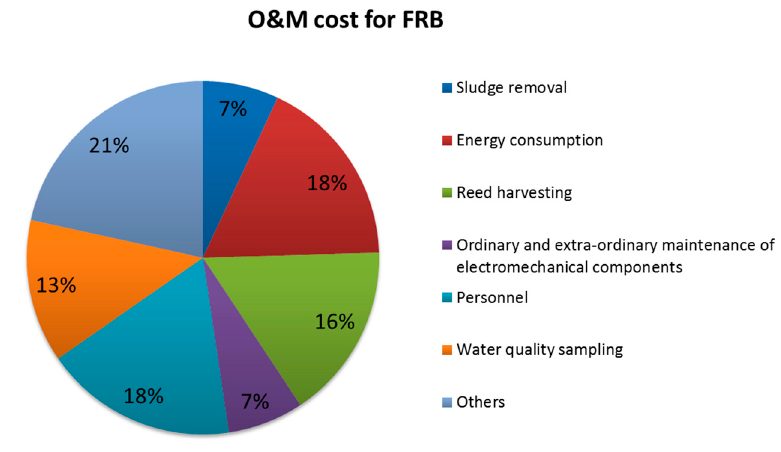
Figure 3. Relative contribution of expenditure items to yearly O&M costs of the FRB WWTP of Castelluccio di Norcia.